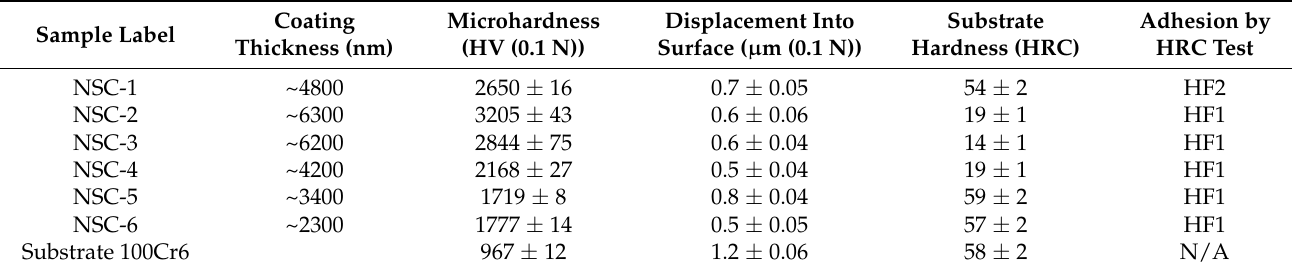
Table 4. Overview of the NSC micromechanical properties.